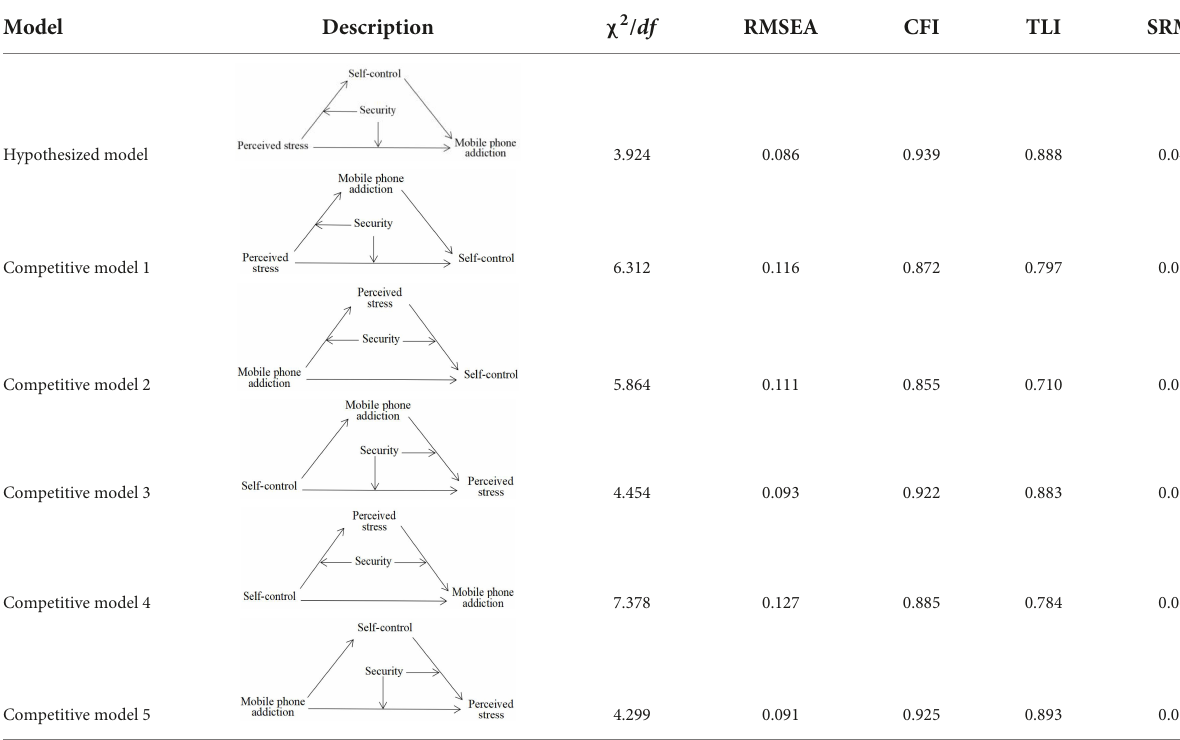
TABLE 5 Hypothesized model and competitive model fitting